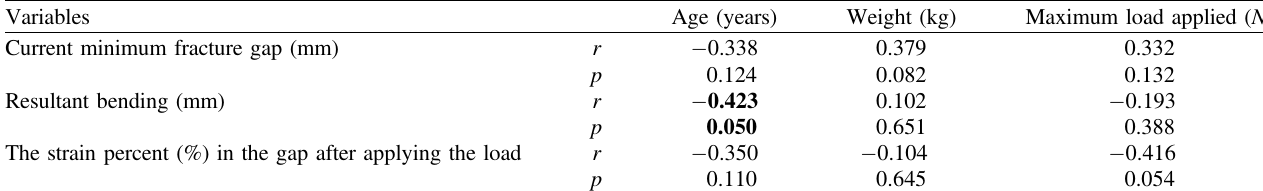
Table 1. Investigated correlations.